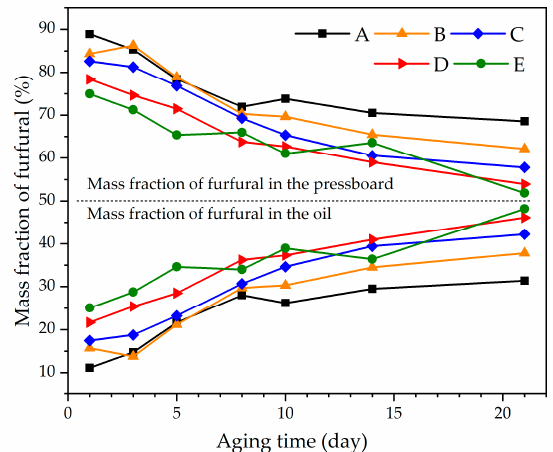
Figure 8. The relationship between furfural mass fraction and aging time.